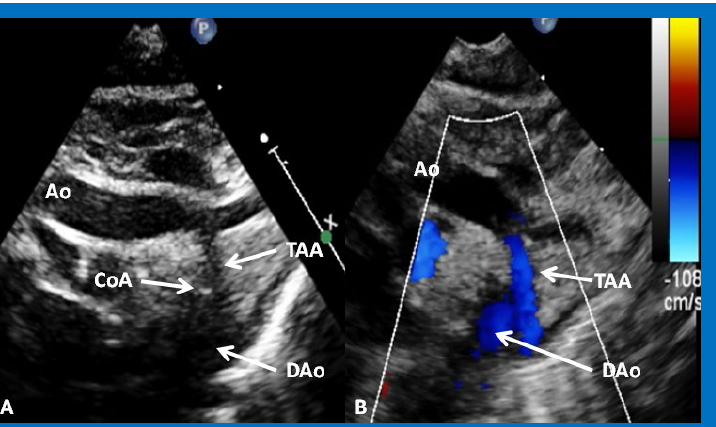
Figure 15. Selected video frame of continuous wave Doppler across the ventricular septal defect of the same patient, as is shown in Figure 11. The low velocity flow across the ventricular septal defect suggests that the defect is nonobstructive. Reproduced from Reference [29].